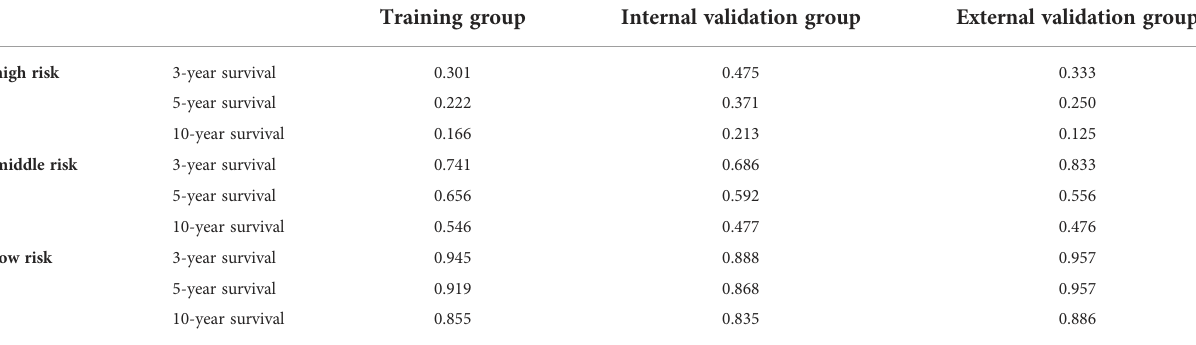
TABLE 3 3-, 5-, and 10-year overall survival in high-, intermediate-, and low-risk groups for each cohort.